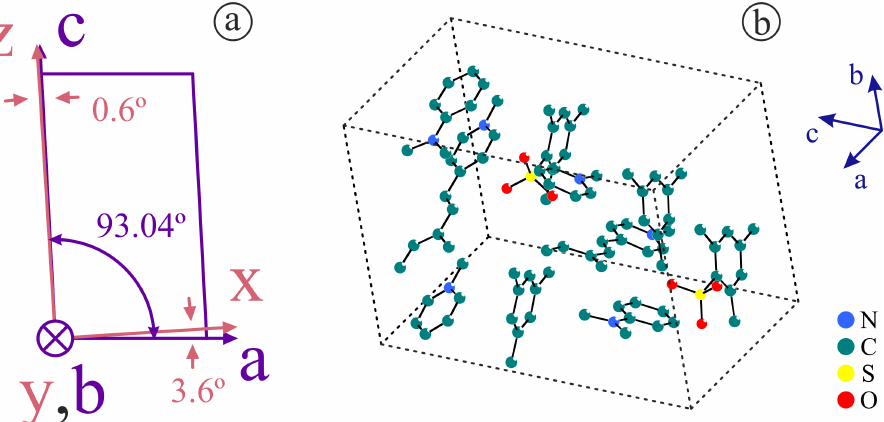
Figure 11. ( a ) Assignment of crystallographic and principal dielectric axes of the monoclinic formation of DSTMS; ( b ) Crystal structure of DSTMS (the .cif files taken from the CCDC database can be found in the Supplementary Materials).